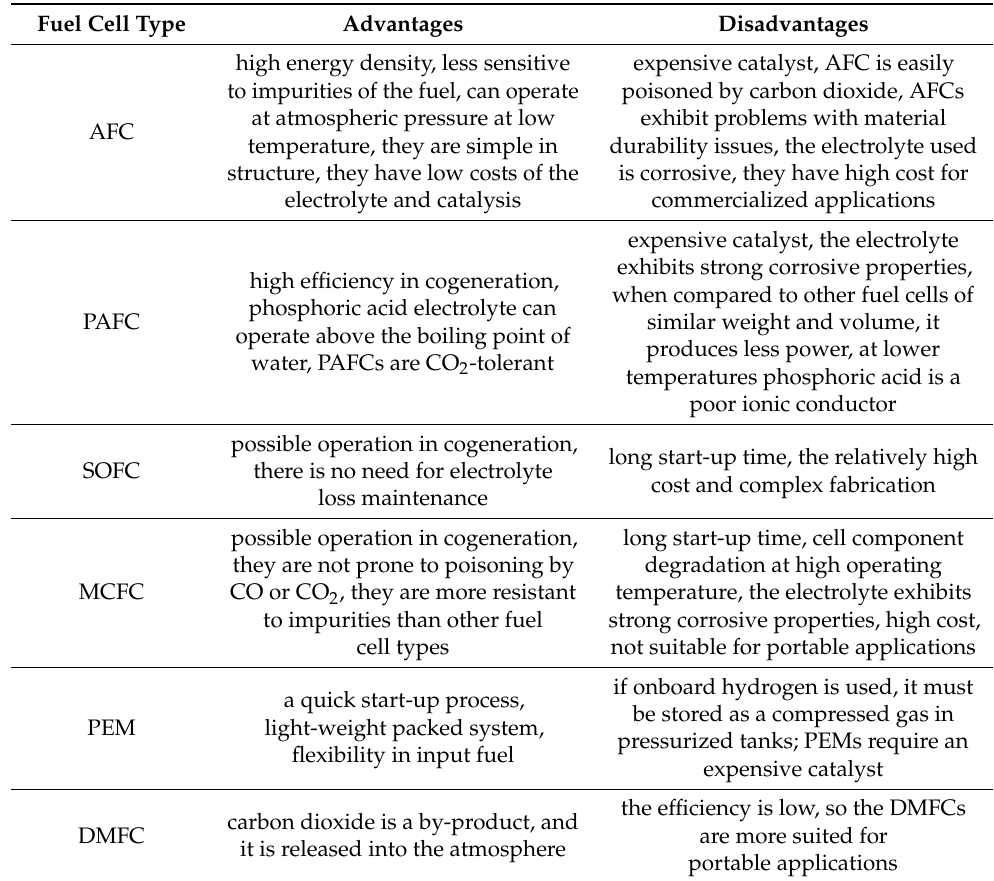
Table 2. Main advantages and disadvantages of selected fuel